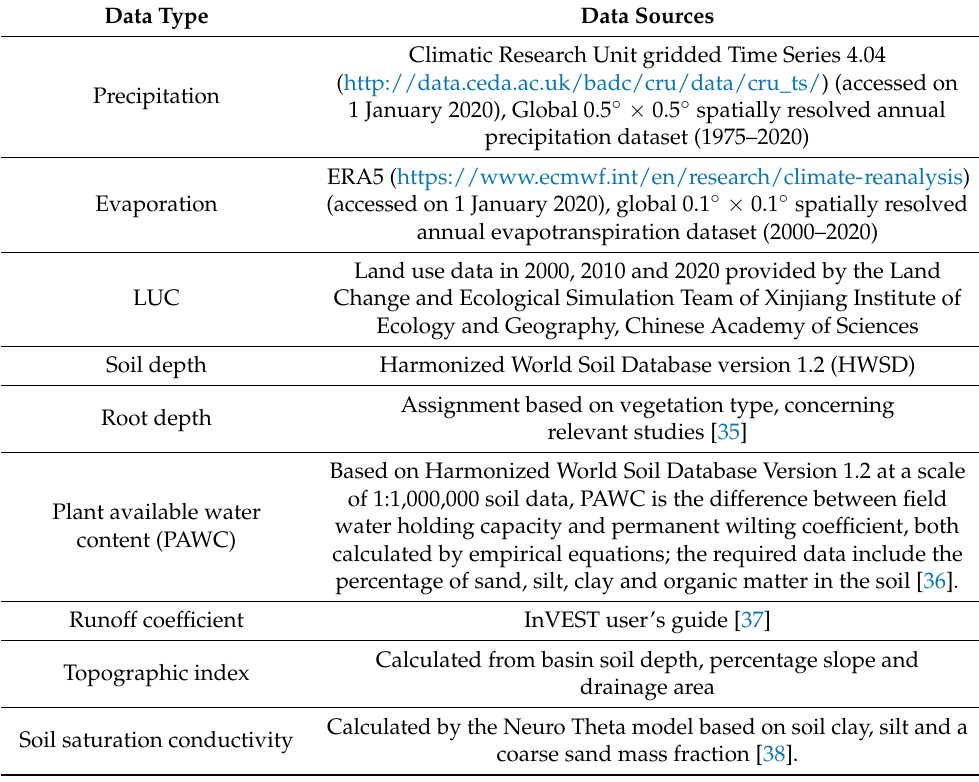
Table 1. Data source and parameter processing details.